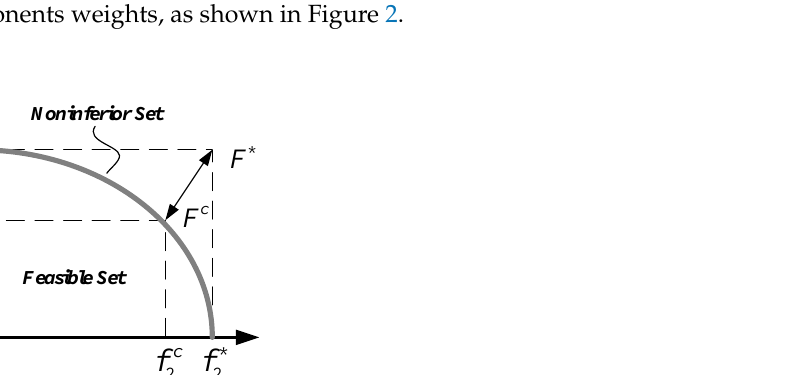
Figure 2. Ideal and compromise solutions. Here, F ∗ is the ideal solution. f ∗ represents the desired/aspired level of Factor 2. The compromise solution, F c is a feasible solution that is “closest” to the ideal F ∗ . A compromise means an agreement established by mutual